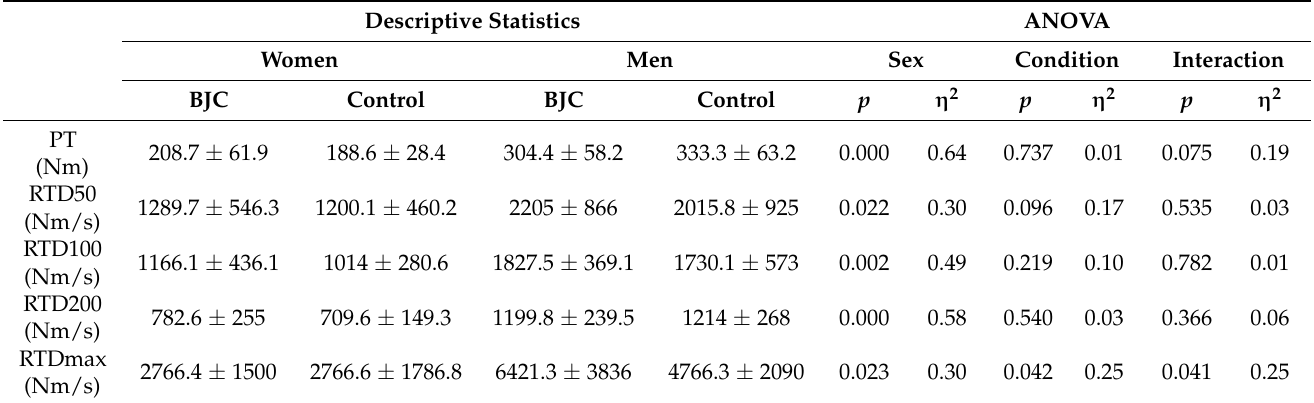
Table 2. Descriptive statistics and main effects for peak torque and rate of torque developments outcomes.